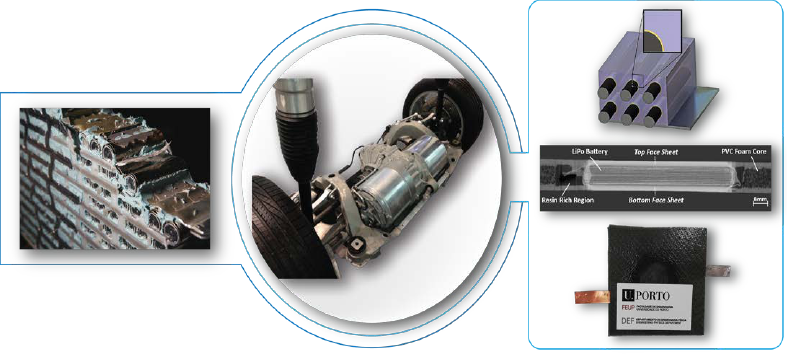
Figure 1. Structural power composites as an alternative to battery pack dead weight.